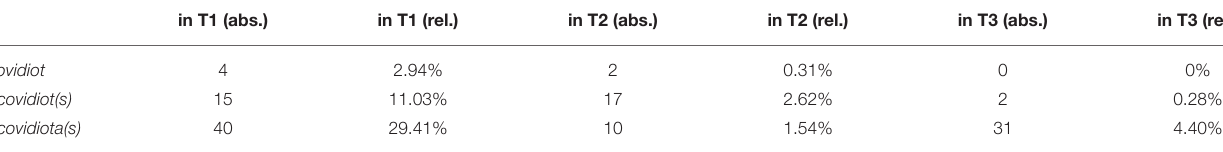
TABLE 3 | Covidiot , #covidiot(s), and #covidiota(s) : numbers per observation period. in T1 (abs.)